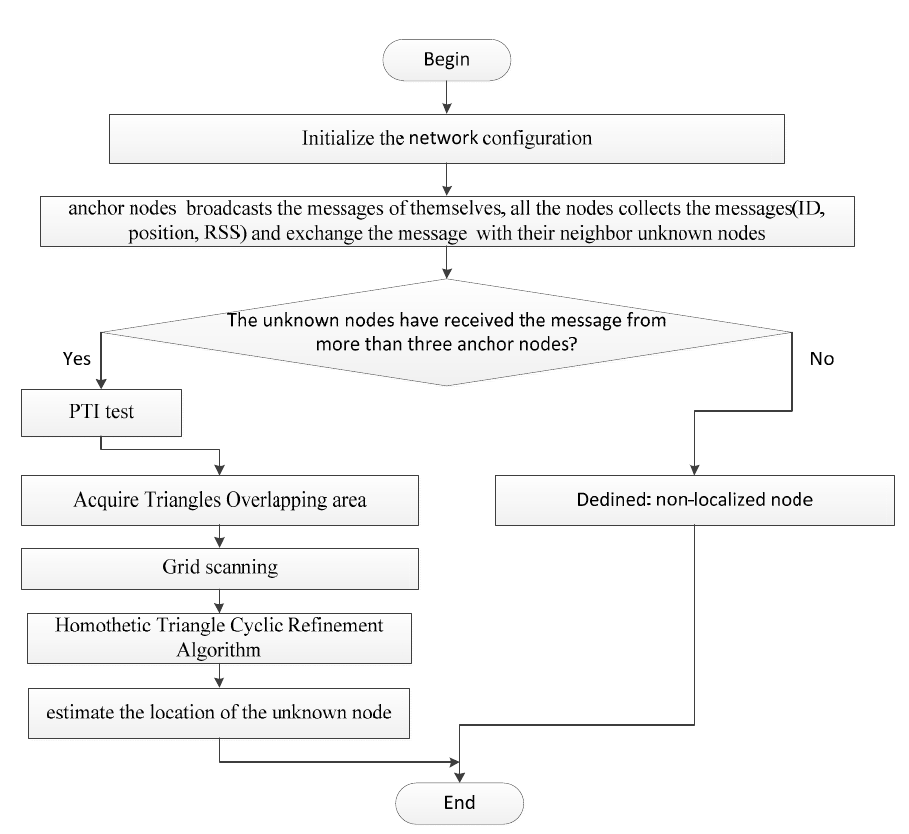
Figure 10. The Main Process of HTCRL Localization Algorithm.